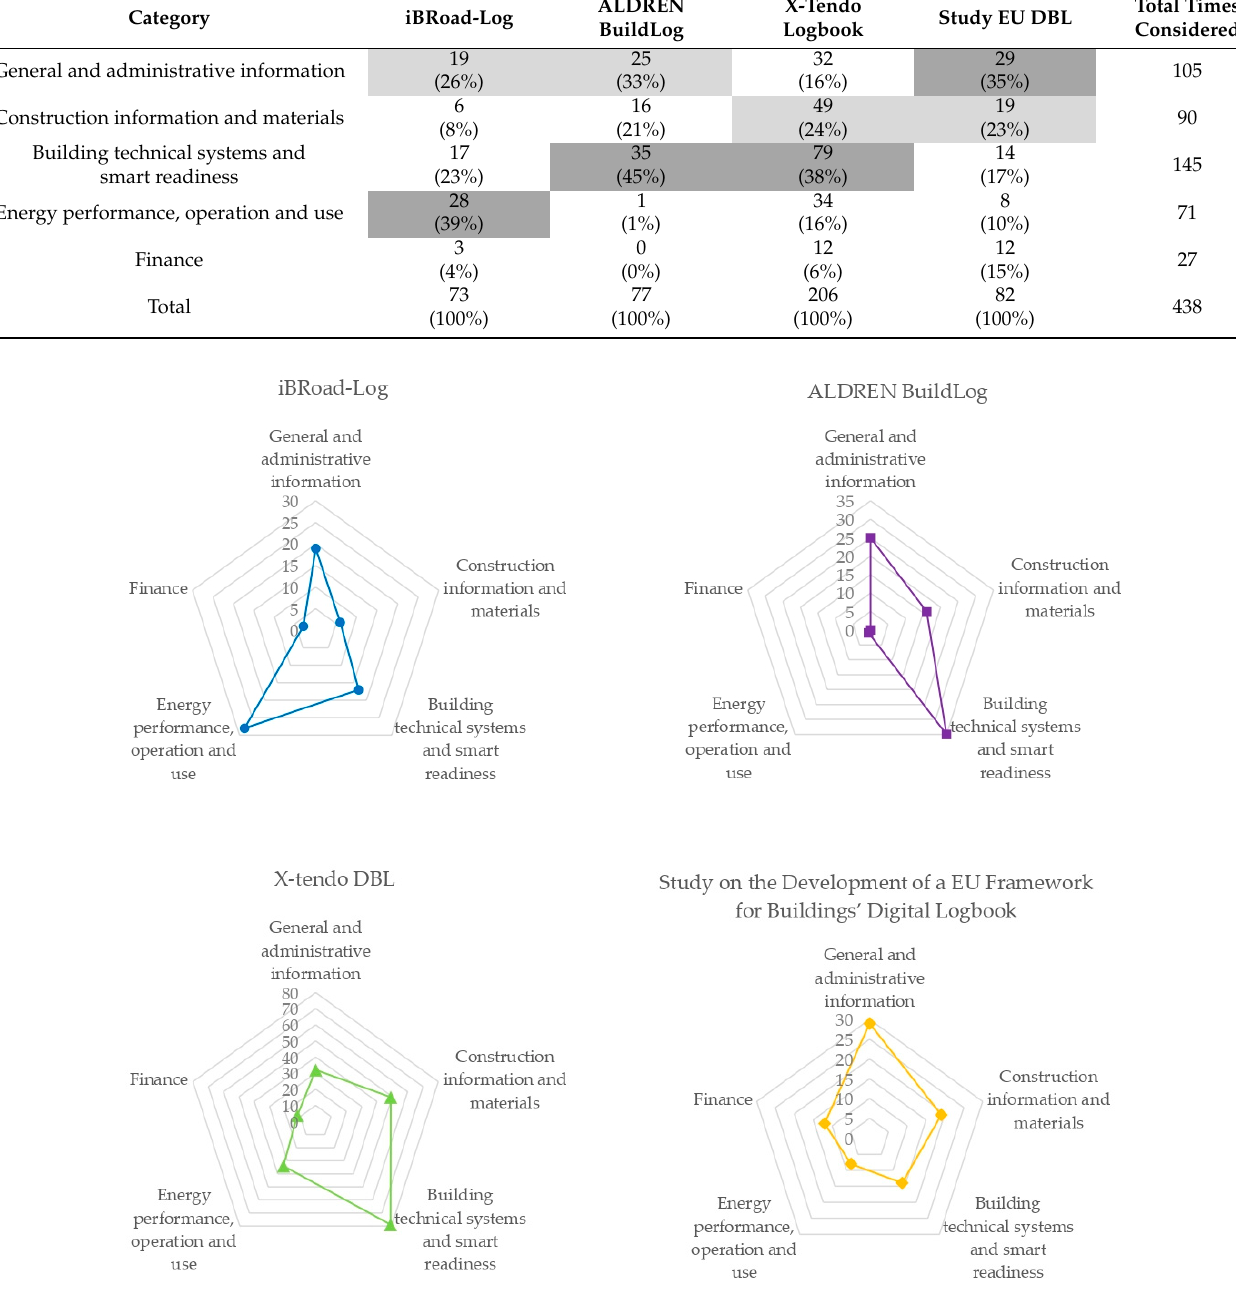
Figure 1. Data categories in studied DBL initiatives.